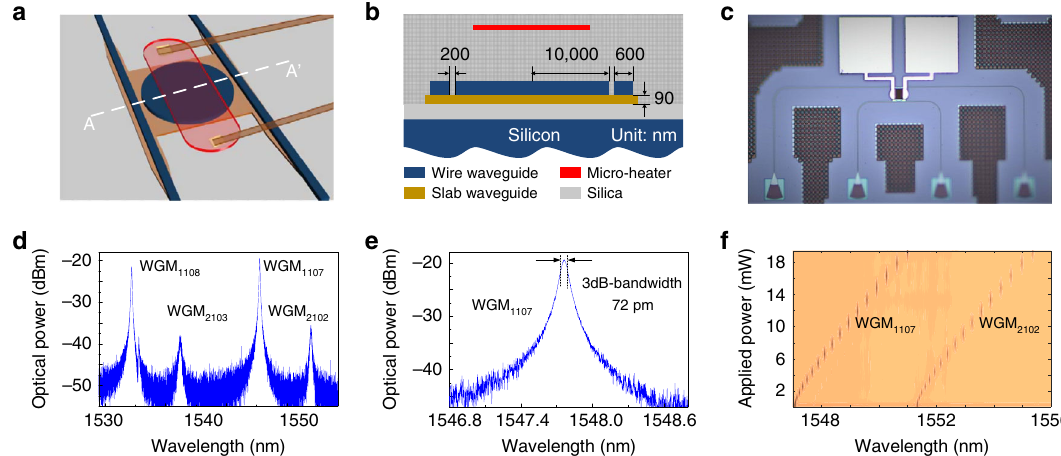
Fig. 2 Design of the microdisk resonator (MDR). a Perspective view of the thermally tunable MDR. b Cross-sectional view of the MDR along the dashed line AA ’ shown in ( a ). c Micrograph of the fabricated MDR. d Spectral response of the MDR from the drop port. e Zoom-in view of the WGM 1,107 , the 3-dB bandwidth is 72 pm. f Spectrum tuning of the MDR by applying a voltage to